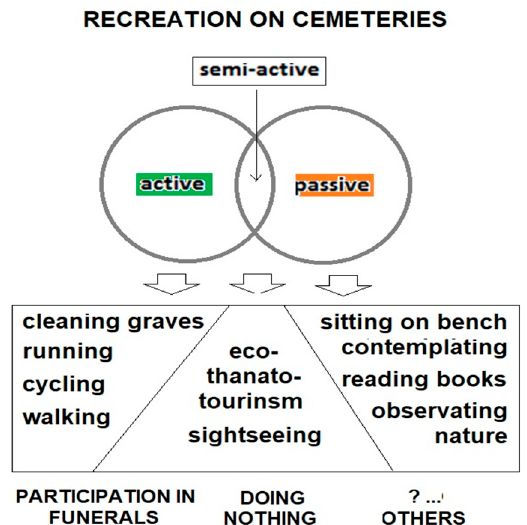
Figure 8. Relationship of overlapping fields of active, semi-active, and passive recreation in cemeteries observed during site observation research in cemeteries in Poland and Germany.